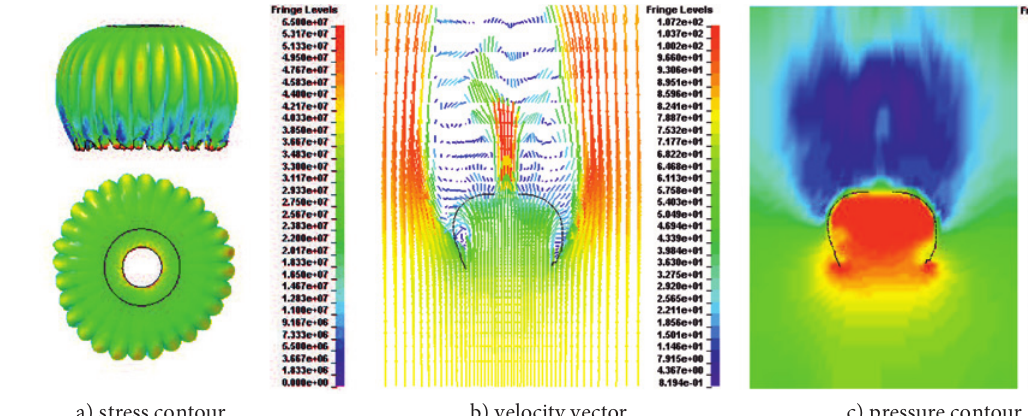
Fig. 7. Structural an d flow fie ld results a t t = 0.675 s